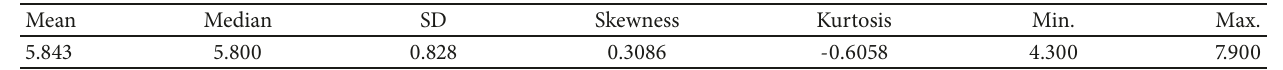
Figure 4: Normal probability plots for 𝑞𝑟 𝑖 in the OLLGIG regression model for scenario 2 ( 𝜏 = 1.5 ) (a) 𝑛 = 100 . (b) 𝑛 = 300 . (c) 𝑛 = 500 . Table 3: Descriptive statistics for iris flower data.